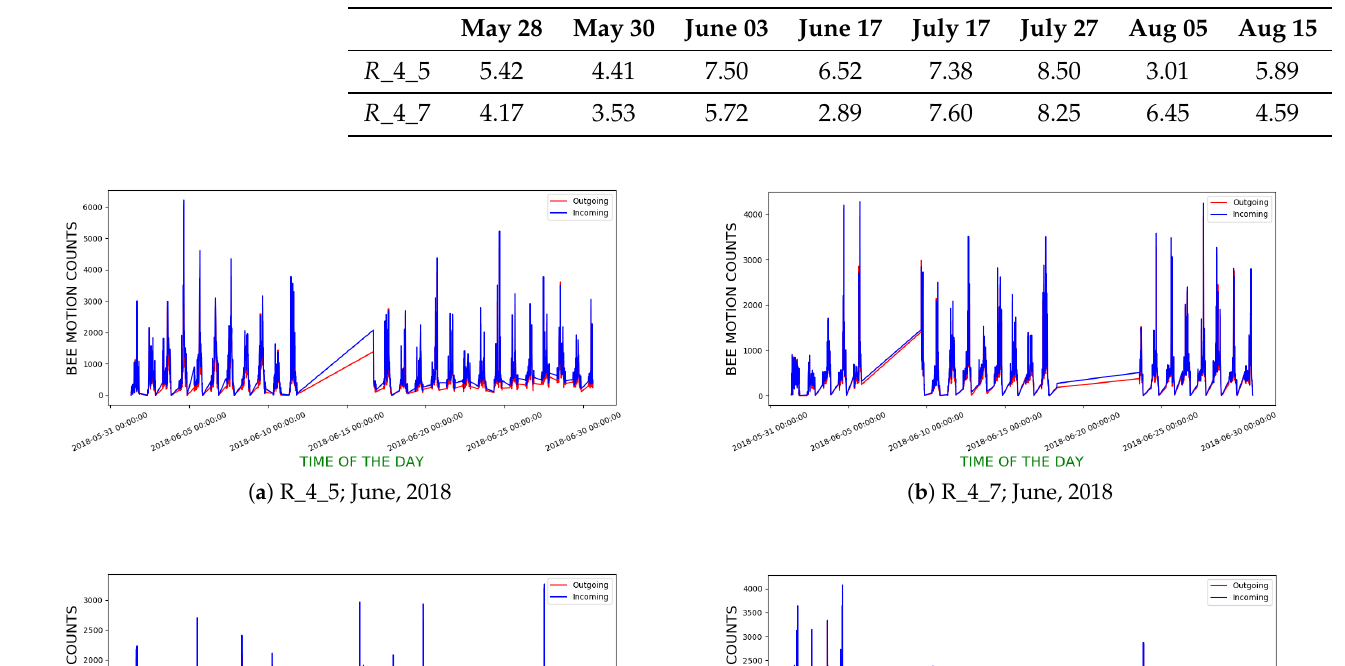
Table 3. DTW scores between outgoing and incoming curves in Figure 18 and several other days in 2018 beekeeping season; lower DTW values reflect closer curve alignments.